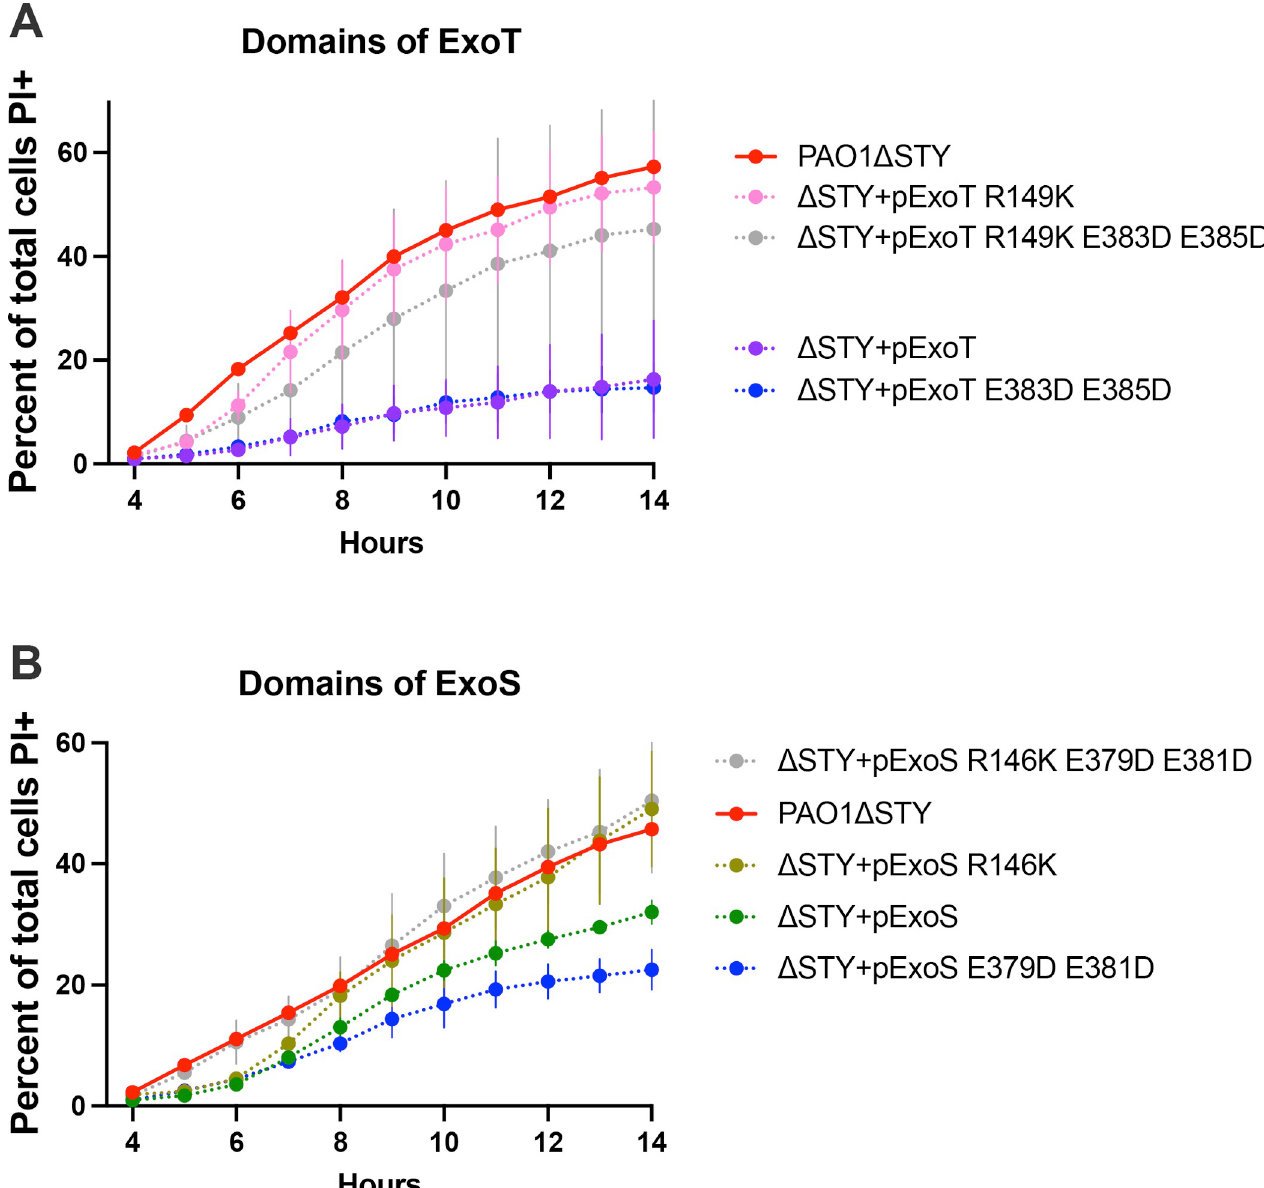
Fig 4. RhoGAP domains of ExoT or ExoS and the ExoS ADPR domain reduce or delay host cell death. HeLa cells were infected with PAO1 Δ exoSTY complemented with indicated plasmids to determine the role of individual domains of ExoT (A) or ExoS (B) for 3 h, then extracellular bacteria eliminated with amikacin. Hoechst and PI were included in the media. Time-lapse images were captured once per hour beginning at 4 h. Hoechst-positive and PI-positive nuclei were counted with ImageJ macro at each time point. Data are expressed as the mean ± SD. Results shown are combined from at least three independent experiments. Note: SD from PAO1 Δ exoSTY (red line) was removed for better visualization of variability among domain mutants.